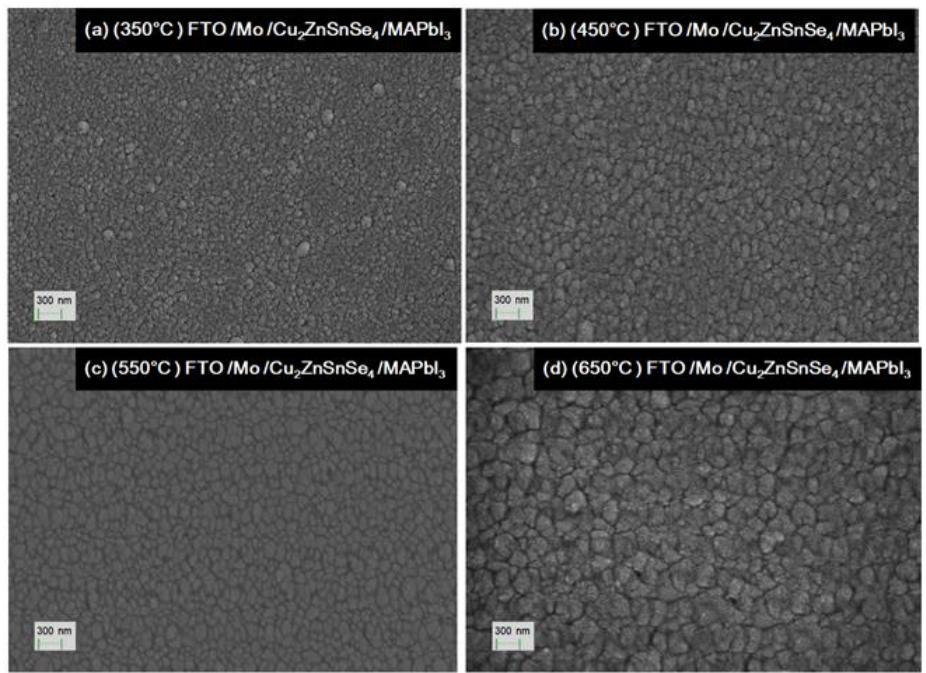
Figure 14. SEM micrographs of MAPbI 3 perovskite films on Cu 2 ZnSnSe 4 /Mo/FTO following the